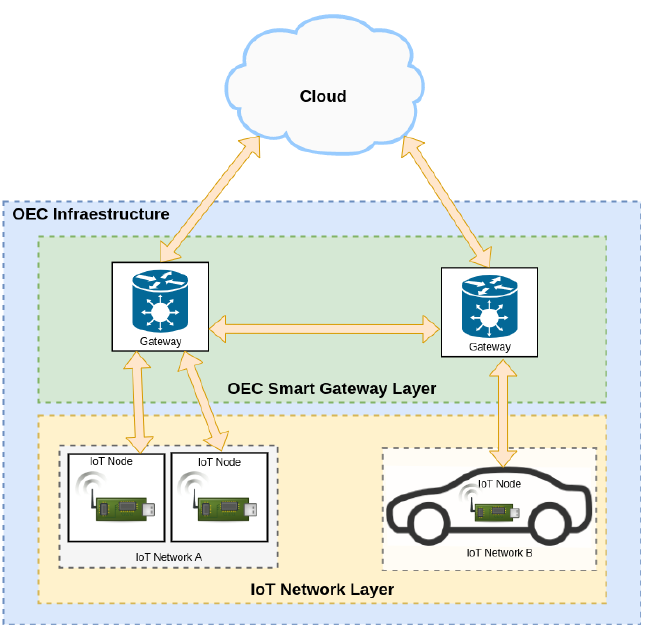
Figure 1. Designed OEC communications